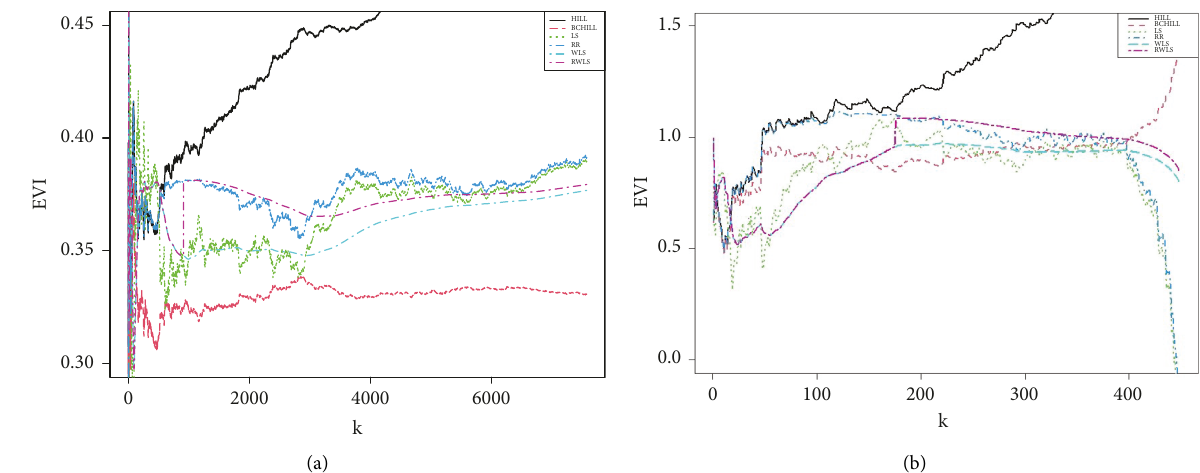
Figure 9: Tail index estimates as a function of k : (a) SOA data; (b) GH